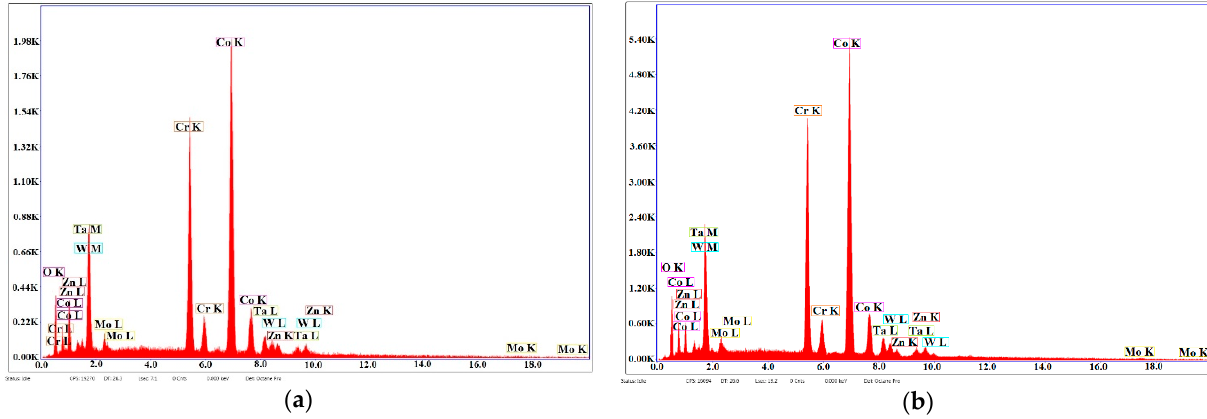
Figure 6. FE-SEM analyses of samples composed of Co-Cr alloy produced by DMLS and coated with a thin film of Ta 2 O 5 (50%) and ZnO (50%) using an e-gun: ( a ) sample S5 without post-treatment; ( b ) sample S6 with post-treatment (×200,000).